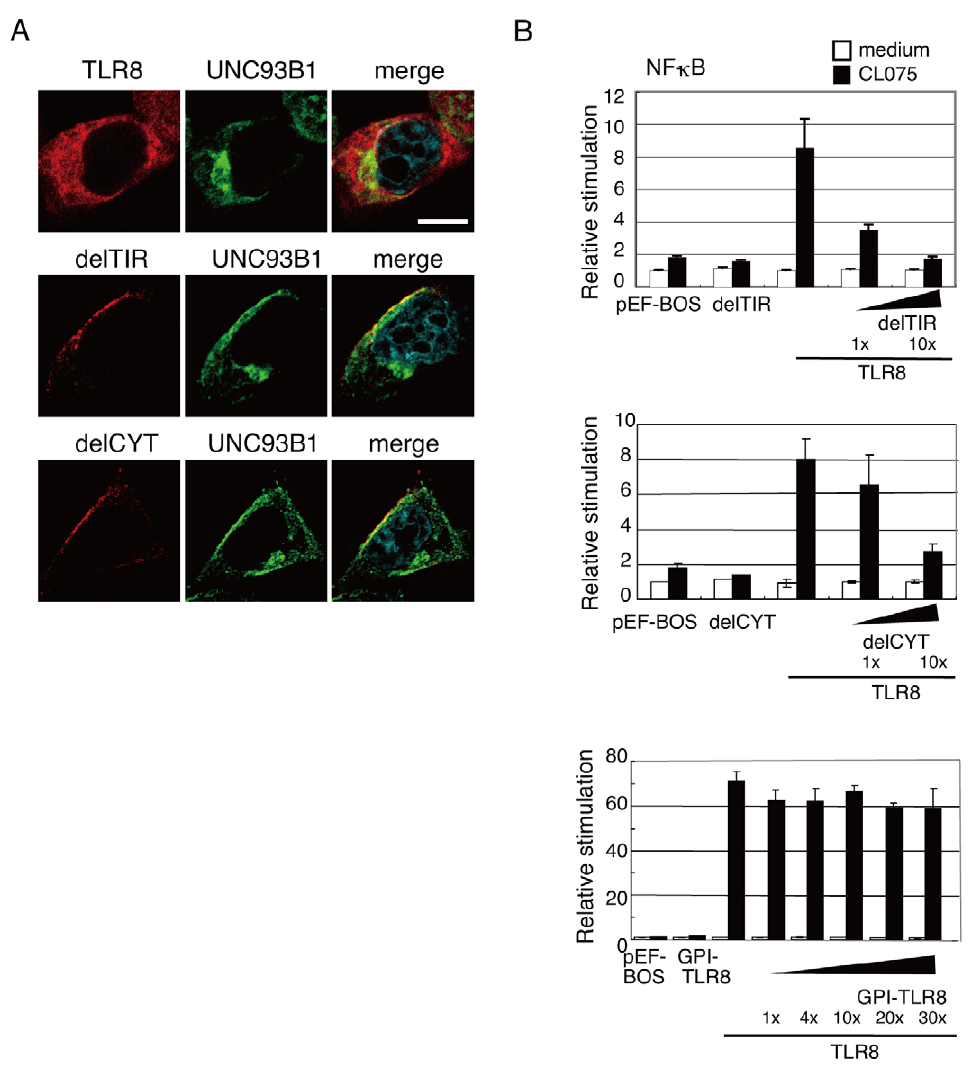
Figure 4. UNC93B1 colocalizes with surface-expressed TLR8 mutants. A , HeLa cells transiently expressing wild-type TLR8, delCYT, or delTIR were incubated with anti-FLAG mAb and anti-human UNC93B1 pAb followed by an Alexa Fluor 568-conjugated anti-mouse IgG and Alexa Fluor 488- conjugated anti-rabbit IgG. Representative confocal images are shown. Green, endogenous UNC93B1; red, TLR8; blue, nuclei stained with DAPI. Scale bar:10 m m. B , Surface-expressed TLR8 mutant proteins inhibited CL075-induced TLR8-mediated NF- k B activation. Luciferase activity of HEK293 cells transfected with the ELAM-promoter-luciferase reporter and expression plasmid for wild-type TLR8 together with increasing amounts of plasmid expressing delTIR (upper graph), delCYT (middle graph), or GPI-TLR8 (lower graph). Twenty-four hours after transfection, the cells were stimulated with 2.5 m g/mL of CL075 or left untreated. After 24 hours, the luciferase reporter activities were measured and expressed as the fold induction relative to the activity of unstimulated cells. Representative data from a minimum of three separate experiments are shown (mean and s.d. of triplicate assays).